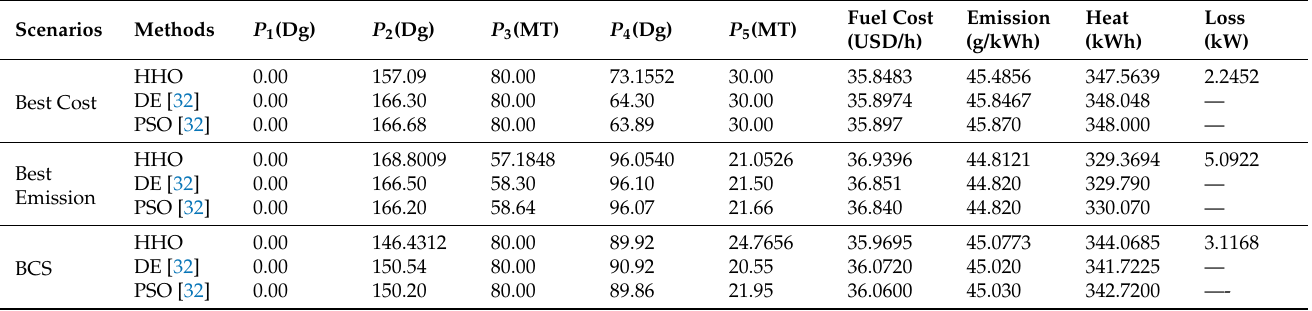
Table 4. Generation schedule and comparative results for SCHPEED with demands of 338